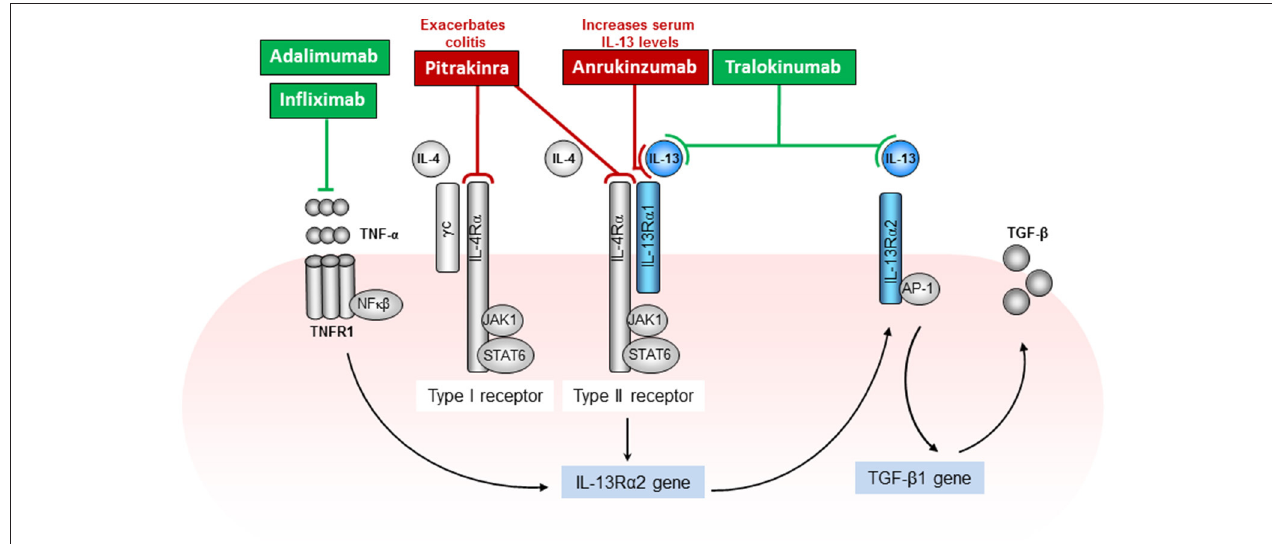
FIGURE 2 | IL-13 signaling mechanisms and associated host directed targets in the treatment of ulcerative colitis. IL-13 signals through the type II (IL-4R α and IL-13R α 1) receptor complex and activates the JAK1/STAT6 pathway. In addition, IL-13 has also been shown to signal through IL-13R α 2, activating AP-1 to induce the secretion of TGF- β . This pathway is, in part dependent on the production of TNF α . Various drug targets have been directed at IL-13 including the IL-4R α signaling pathway to block the immune response that mediate Th2-driven inflammatory diseases such as allergy and colitis. Drug treatments that were beneficial or improved disease outcome are depicted in green and treatments that were unsuccessful or exacerbated disease outcome are depicted in red (Rutgeerts et al., 2005; Wenzel et al., 2007; Levin and Shibolet, 2008; Reinisch et al., 2011, 2015; Mannon and Reinisch, 2012; Sandborn et al., 2012; Verma et al., 2013; Colombel et al., 2014; Feagan et al., 2014; Danese et al., 2015; Palamides et al., 2016; Hoving et al., 2017; Popovic et al., 2017).